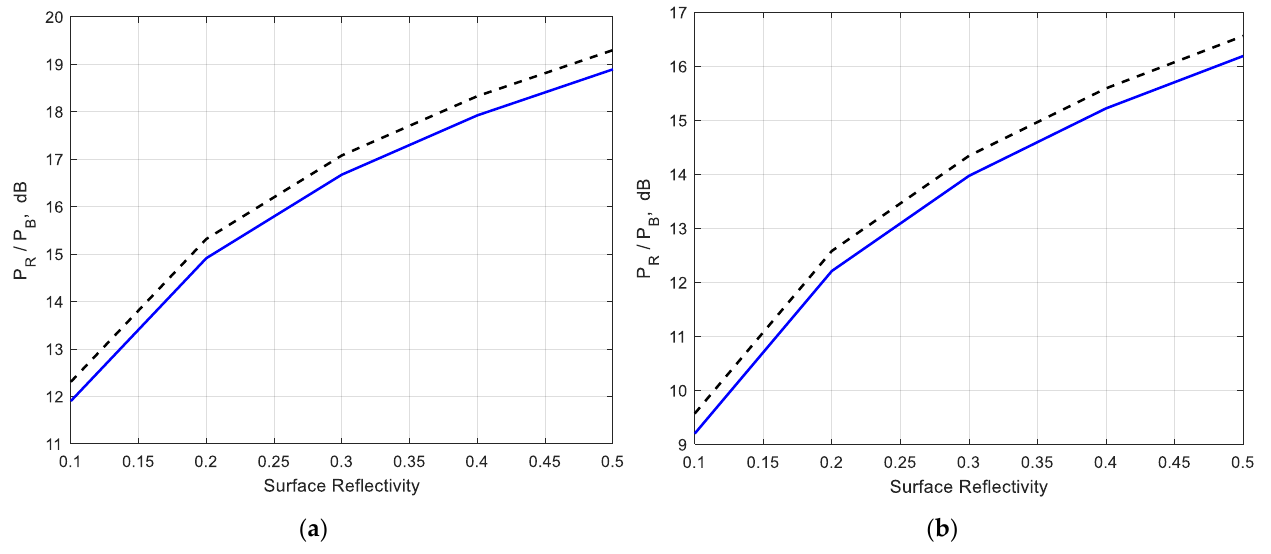
Figure 7. Scene-to-brownout backscatter ratio vs. surface reflectance; solid line ( ― ) — (23), (27) with Mie solution; dashed line ( ‒ ‒ ) — (23), (27) with Rayleigh approximation. Distance to the surface L = 30 m; ( a ) ε = 5.5 − j 5.15 × 10 −2 ; ( b ) ε = 3.5 − j1.65.